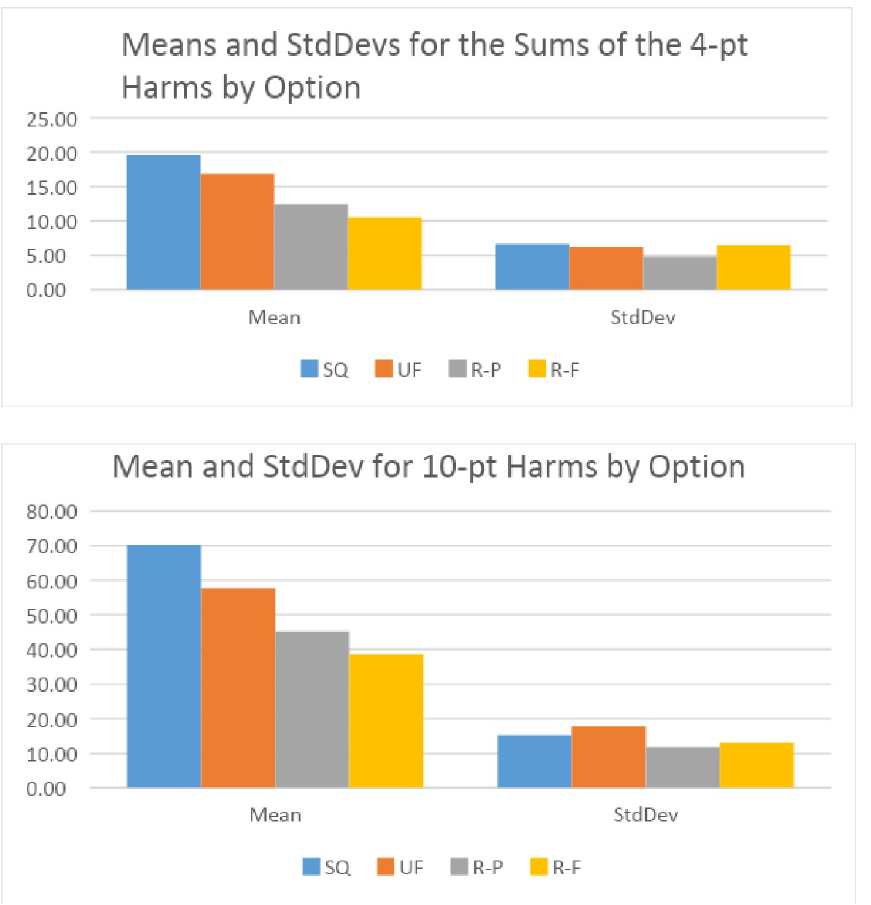
Fig 7. Means and standard deviations for the sums of the harms (by respondent) based on 4-point and 10-point ratings.